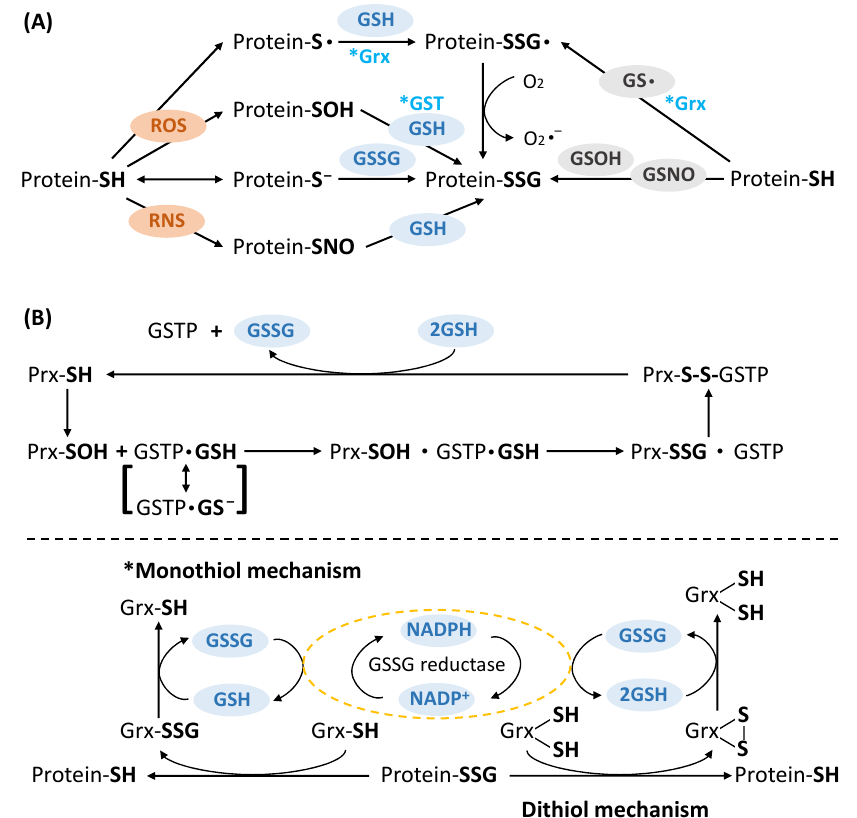
Figure 2. ( A ) Potential molecular mechanisms of protein glutathionylation. ( B ) Protein glutathi-